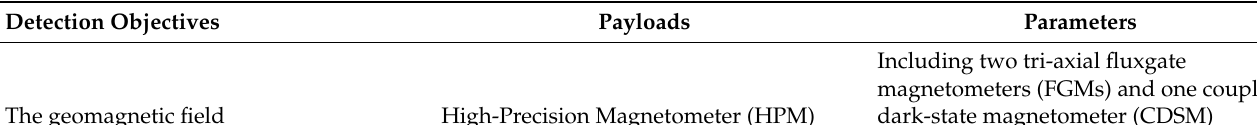
Table 1. The scientific payloads onboard